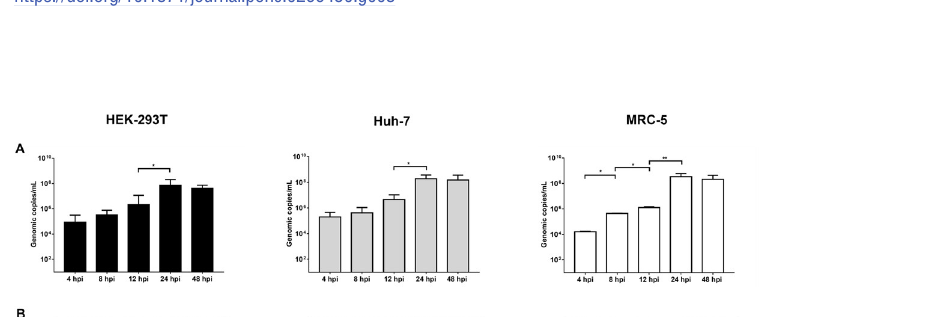
Fig 3. Assessment of CHIKV infection by immunofluorescence. Cells were exposed to CHIKV isolate at MOI 1. At 48 hpi, the cells were fixed, permeabilized, stained with anti-E1 CHIKV antibody.